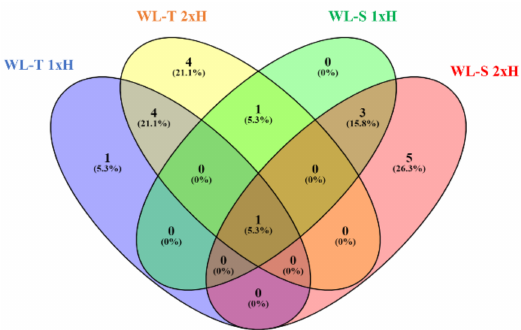
Figure 9. Venn diagram with common and specific miRNAs differentially expressed under hypoxic conditions (1xH, 2xH) in two cucumber accessions, i.e., WL-T and WL-S, compared to control.